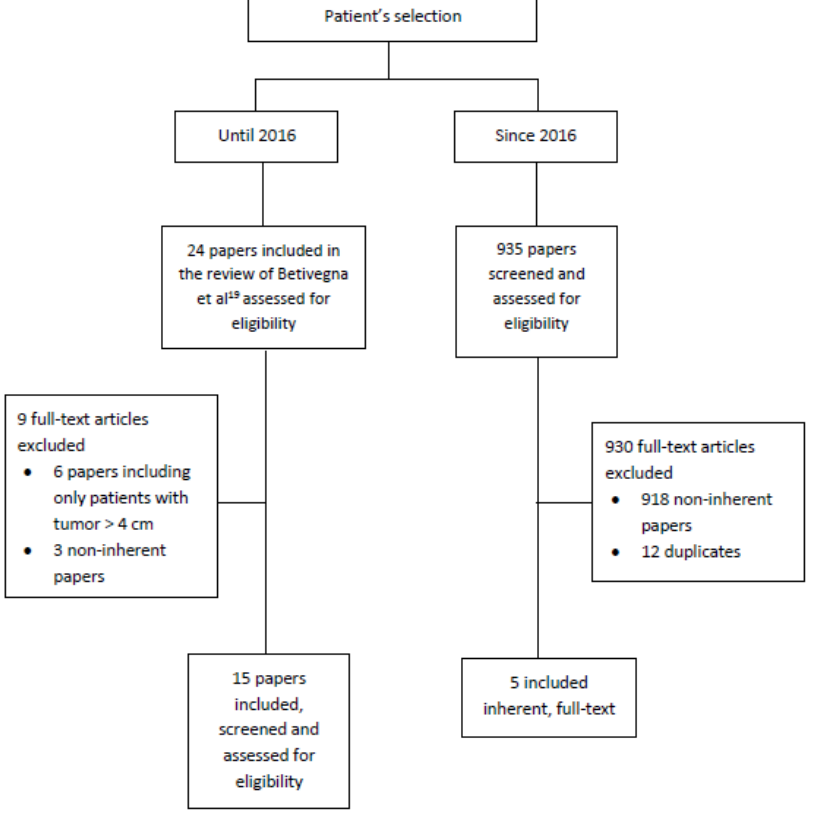
Figure 1. PRISMA 2009 flow diagram.